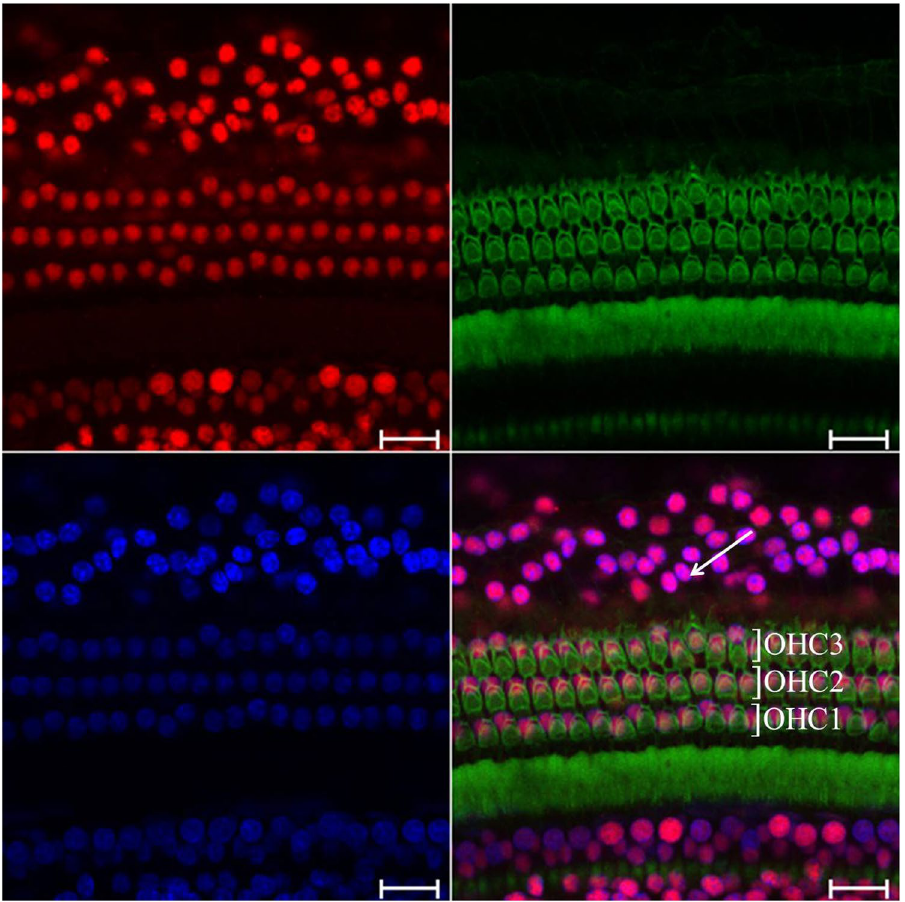
Figure 2. Examples of HDAC2 immunolabeling in the cochlea by whole-mount technique. FITC-conjugated phalloidin (green) and DAPI (blue) were used to label stereocilia and nuclei, respectively. Positive nuclear immunolabeling of HDAC2 (red) was observed in inner hair cells (IHCs), outer hair cells (OHCs) and Hensen cells (arrow). Scale bars = 20 μ